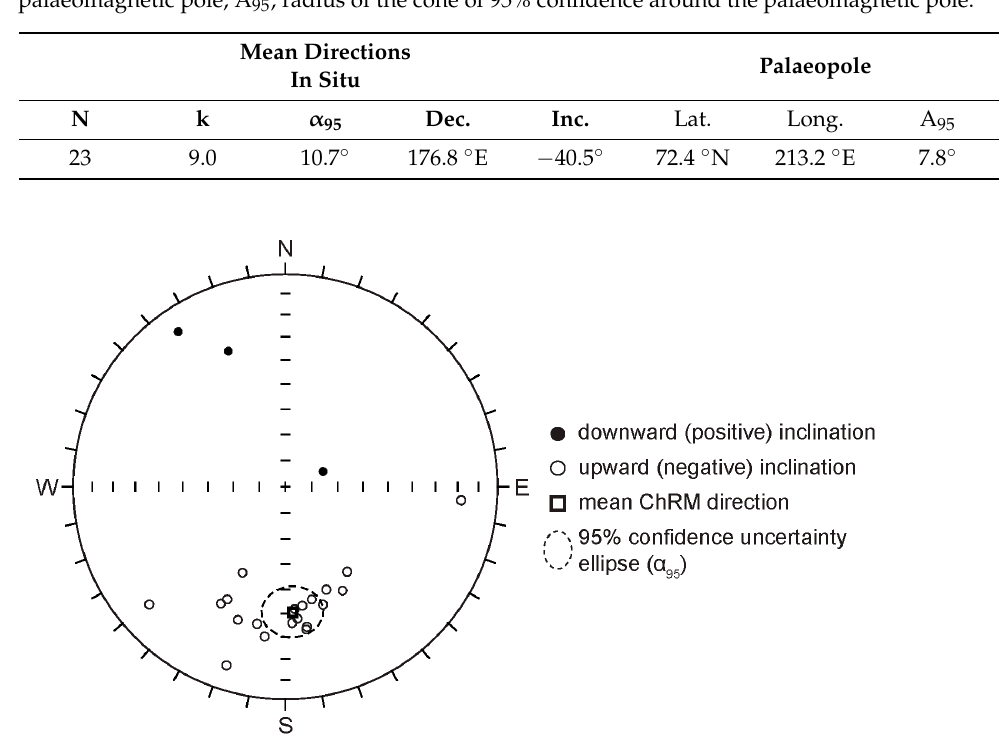
Figure 7. Equal-area projections of the ChRM component directions from the Tsiotra Vryssi section (see Table 3 for mean